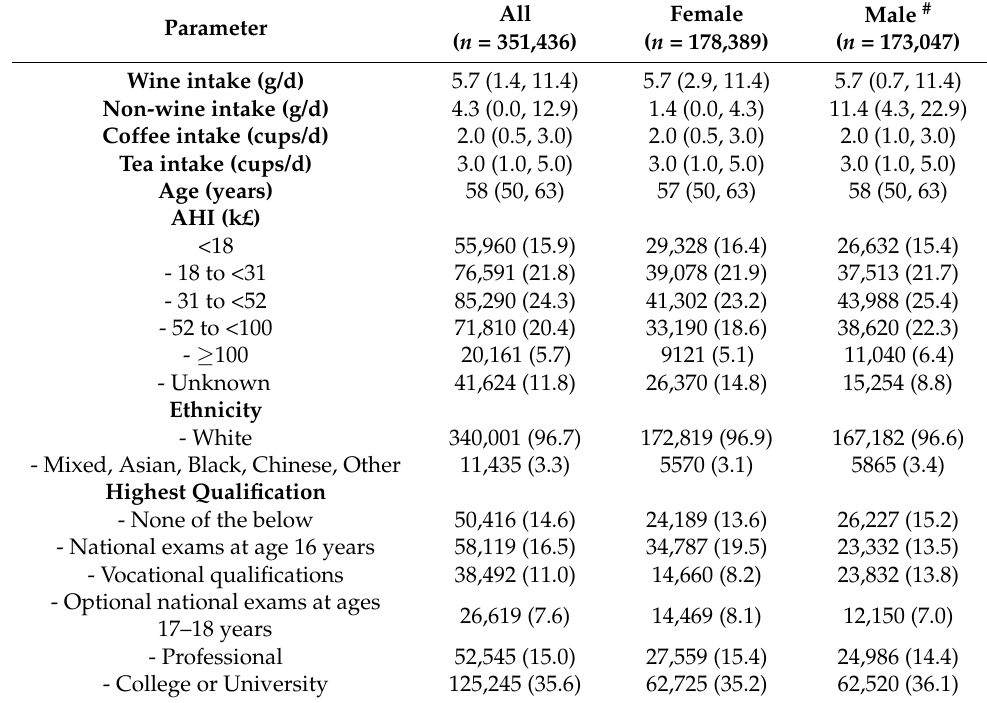
Table 1. Baseline characteristics of the UK Biobank cohort depending on sex 1 .